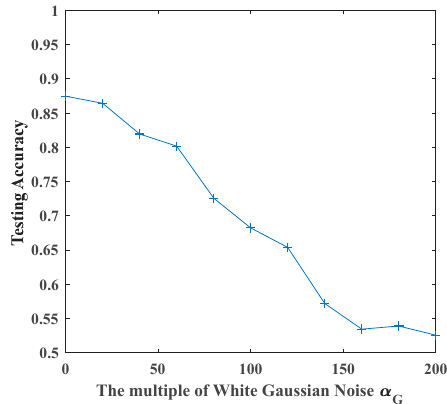
Figure 10. The maximum testing accuracy of original SCN with white Gaussian noise.